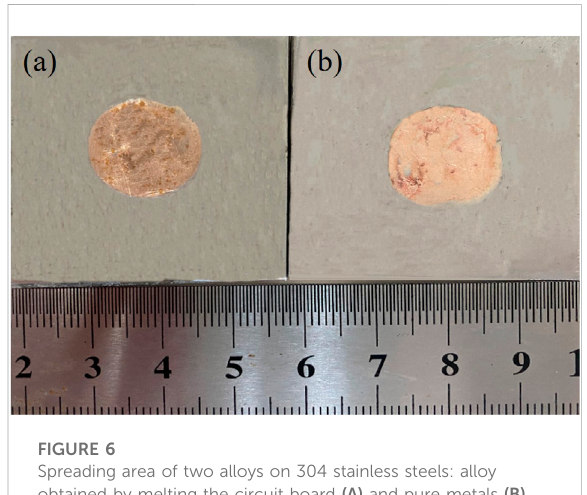
FIGURE 6 Spreading area of two alloys on 304 stainless steels: alloy obtained by melting the circuit board (A) and pure metals (B) .